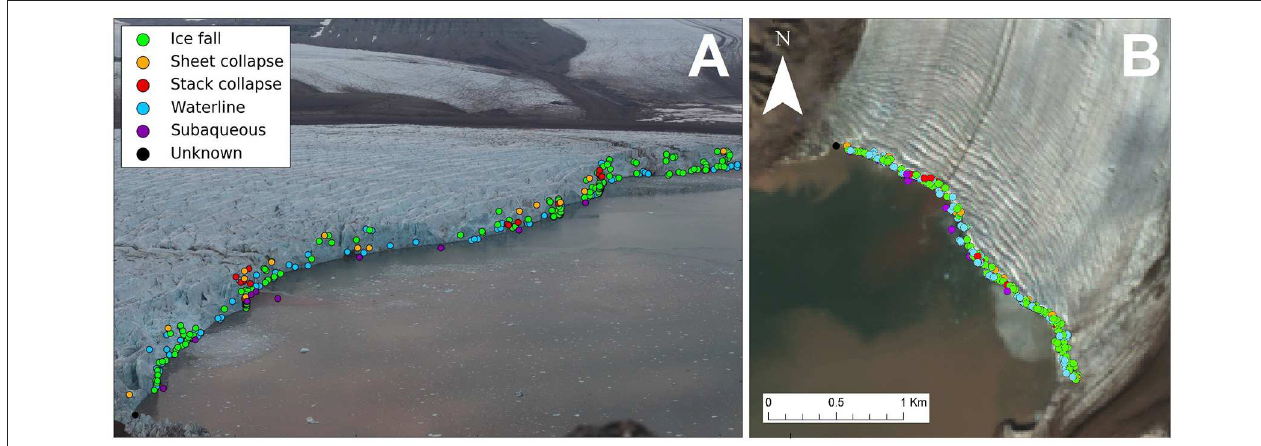
FIGURE 10 | Calving events observed from Tunabreen camera TU1 in the image plane (A) and georectified (B) , with the color of the point denoting the style of calving. Events were manually detected, from which the style of calving was interpreted. The oblique image (A) is taken from a sequence captured between 7 and 8 August 2015. The underlying satellite image (B) is a Landsat 8 image, captured on 17 August 2015. Figure adapted from How et al. (2019). This example is provided with PyTrx at